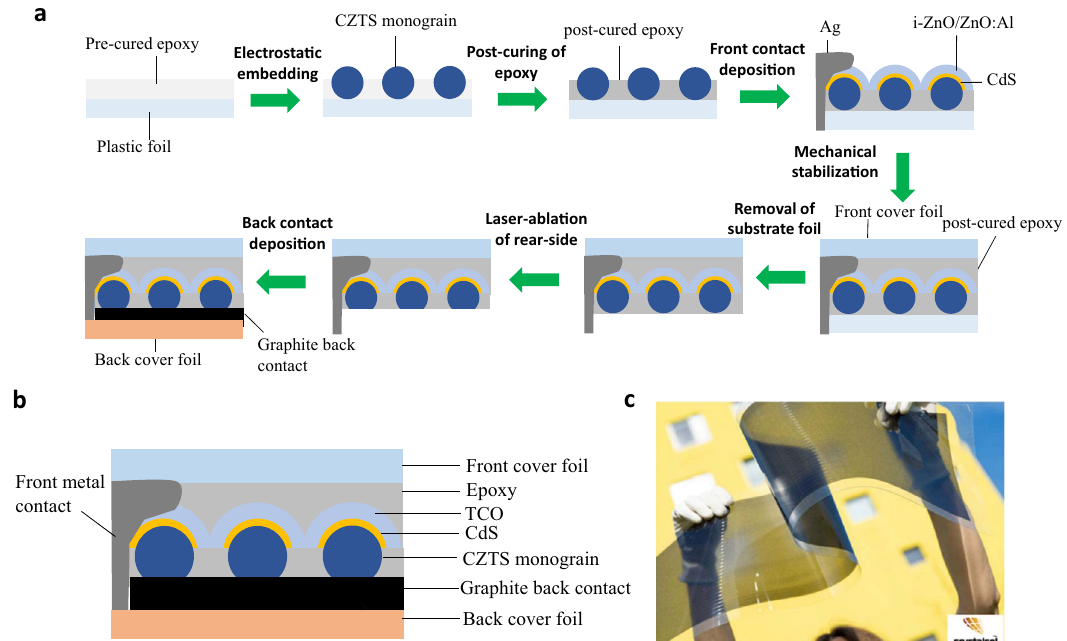
Fig. 4 fl exible monograin layer CZTSSe solar cells. a Process fl ow to fabricate fl exible monograin layer CZTSSe solar cells. b Schematic of the architecture of fl exible monograin layer CZTSSe solar cells. c Photo demonstration of an endless fl exible monograin layer CZTSSe module fabricated by Cystalsol. Reproduced with permission 18